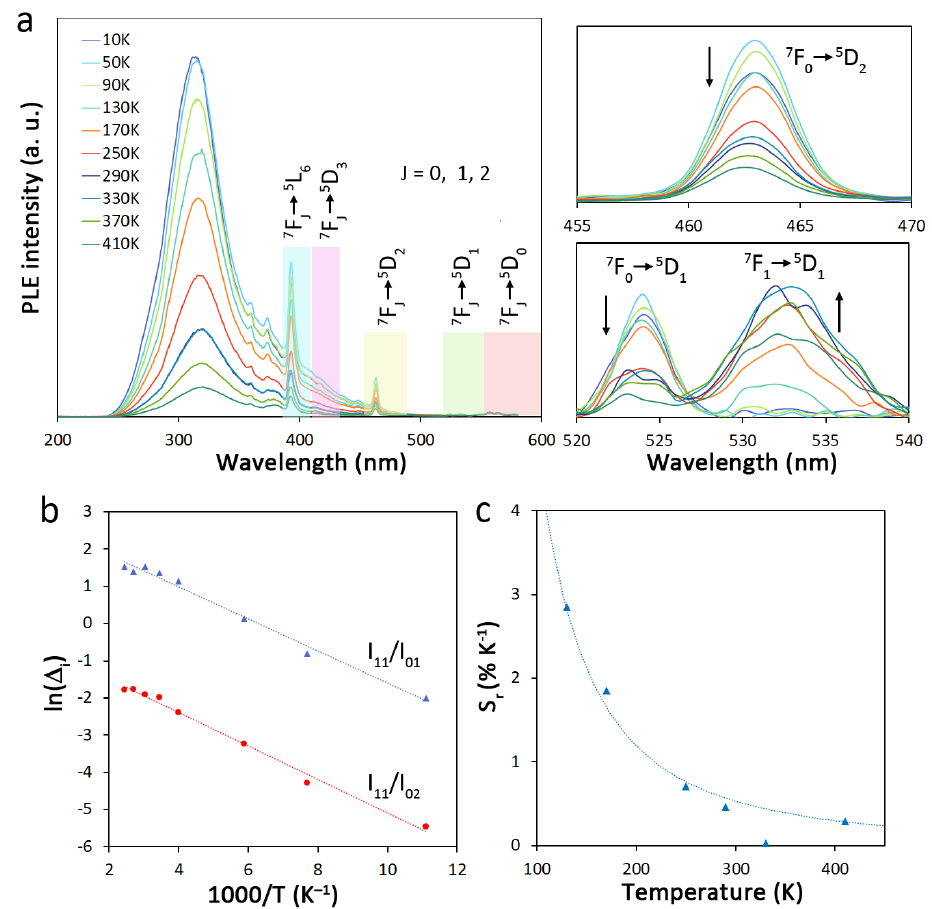
Figure 6. ( a ) Temperature-dependent PLE spectra of PHTF-3Eu monitored at 612 nm. The two insets on the right show a magnification of the bands considered for the assessment of the thermometric properties. The spectra associated to the 7 F 0 → 5 D 2 transition have been corrected for the overlapping contribution of the broad ligand-centered band; ( b ) Dependence of the natural logarithm of the thermometric parameter ln ∆ i from the inverse of the absolute temperature T. The dotted lines represent the best linear regression fit based on Equation (5) (R 2 = 0.987 and 0.991 for the blue and red line, respectively); ( c ) Experimental S r % values at different temperatures (blue triangles). The dotted curve represents the best fit to data according to Equation (7) ( retrieved Δ E = 331 cm − 1 , R 2 = 0.949).